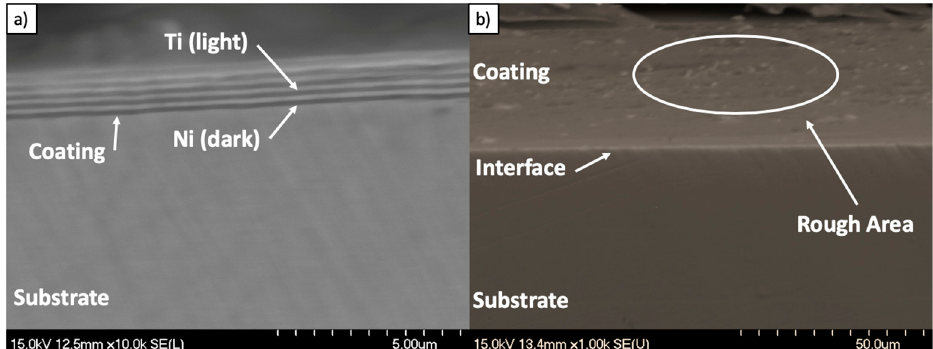
Figure 2. Cross-sections of ( a ) 650 ◦ C nanolaminate and ( b ) superelastic NiTi monolayer coatings.